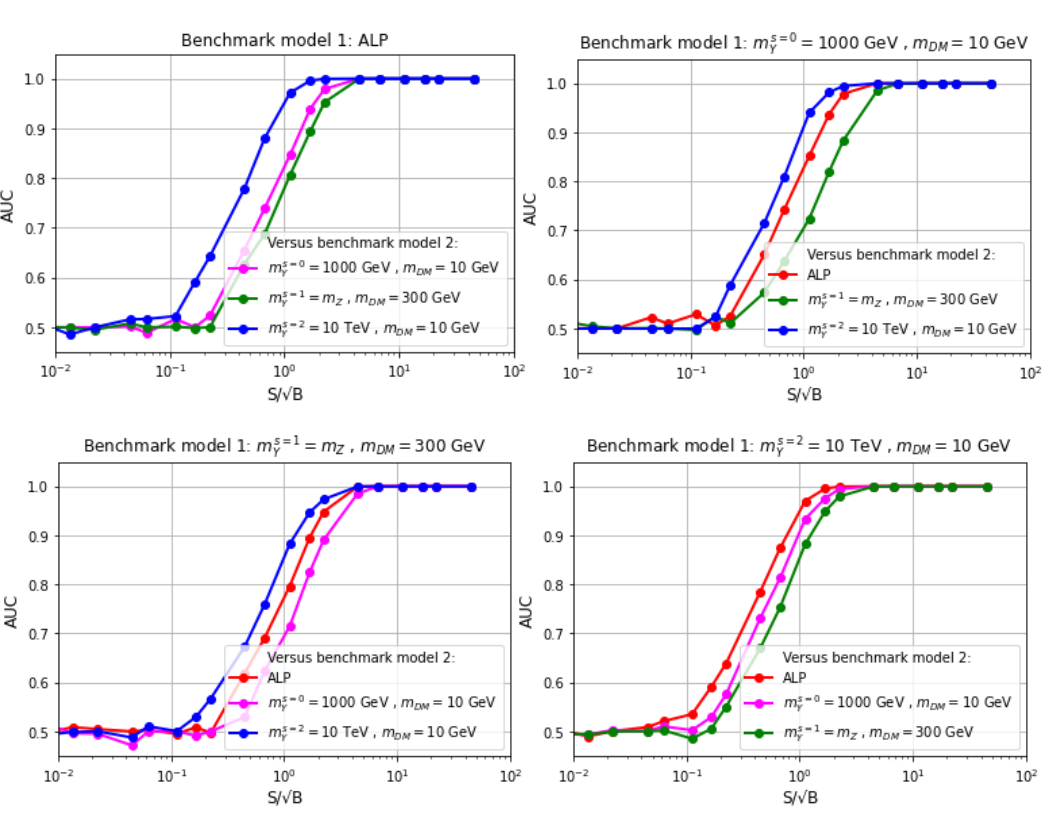
Figure 13: AUC for several binary DM classifiers. Each panel shows the efficiency when discriminating between a benchmark model 1 plus SM, versus a benchmark model 2 plus SM, as indicated on top and in the label of each figure